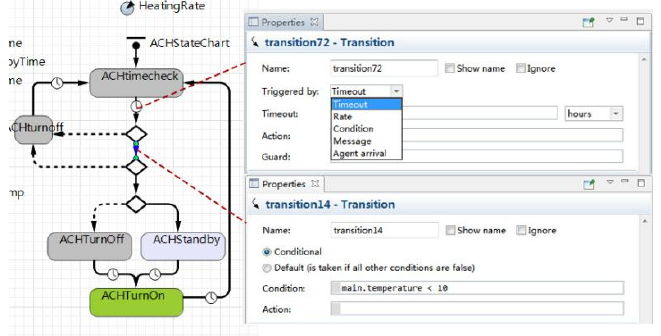
Figure 4. Behavior transformation of air conditioning for heating.